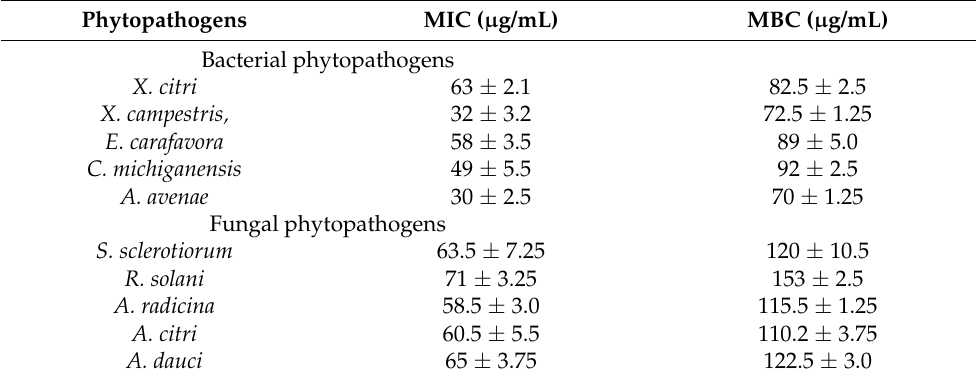
Figure 1. Antibacterial ( A ) and antifungal ( B ) activity of T. hamatum FB10 culture supernatant against pathogenic organisms. Zone of inhibition was expressed as mm diameter. Table 2. Antibacterial and antifungal activities of secondary metabolites against bacterial and fungal